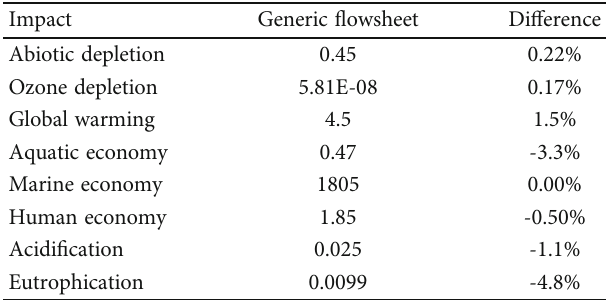
Table 5: Result of